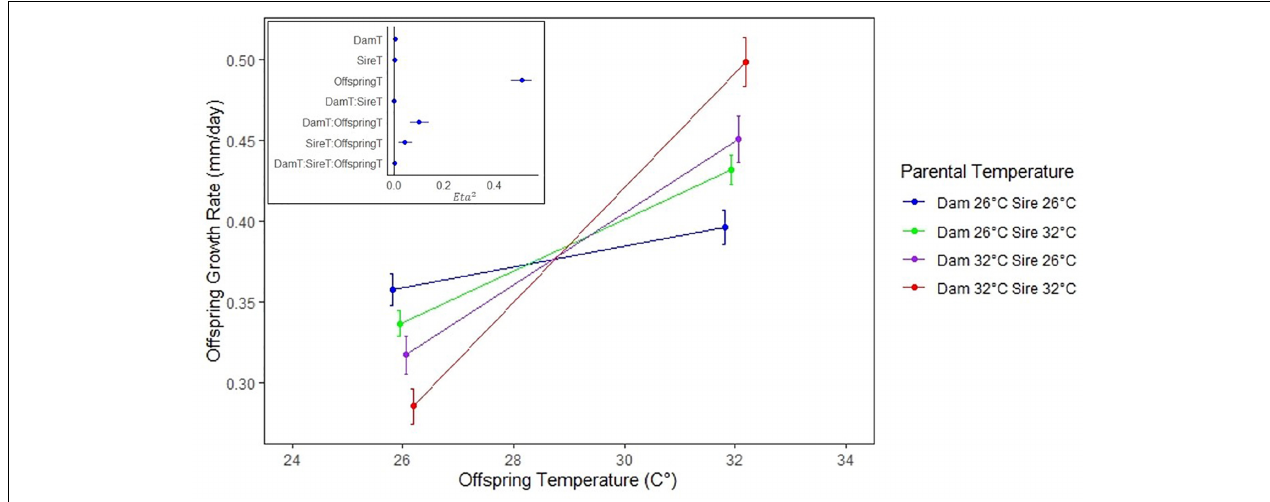
FIGURE 1 | Average growth rate (mm/d) over the first 63 days versus offspring temperature ( ◦ C). The red line indicates growth of offspring whose sire and dam were both at 32 ( ◦ C). Similarly, the purple, green, and blue lines correspond to dam/sire temperatures of 32/26, 26/32, and 26/26, respectively. Note that the fastest growing offspring at each temperature were those whose parents were both at the same temperature. Average growth rates were not significantly different between sire temperatures 26 and 32 within the 26 offspring group, or between dam/sire temperatures 26/32 and 32/26 in either offspring temperature group. Error bars denote 95% confidence intervals. Inset: Eta 2 for ANOVA results over 63 days of growth, where offspring, dam-offspring, and sire-offspring interactions were found to be